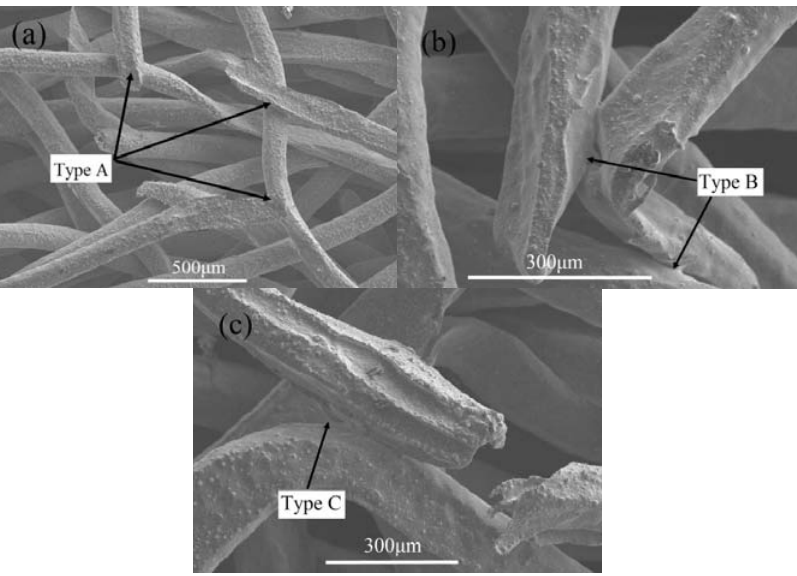
Figure 3. SEM images of bonging types of the stainless steel PTWMs. ( a ) A-type sintering joints; ( b ) B-type sintering joints; ( c ) C-type sintering